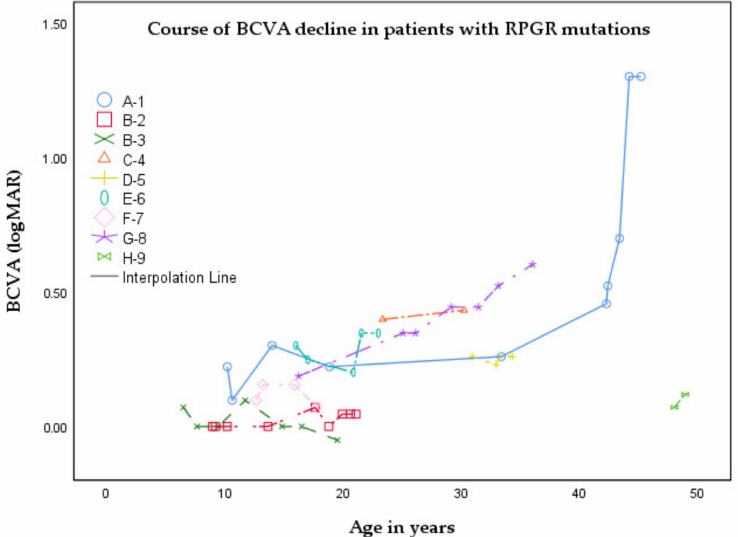
Figure 1. Graph demonstrating the change in mean best-corrected visual acuity (BCVA) in relation to the age in years of this cohort. Snellen BCVA data were transformed into logMAR values. Data from the same subject are shown using interpolation lines connecting the points. All patients had a retinitis pigmentosa phenotype, except for patient H-9, who exhibited a cone-rod dystrophy